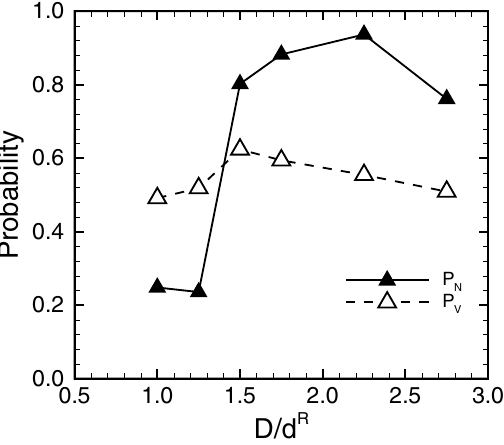
Figure 2. Number probability of MPs in CDPL, P N , and volume fraction of CDPL, P V , for Hct = 0.2 and Ca = 0.2. The microvessel diameter is normalized by that of RBCs, D / d R .